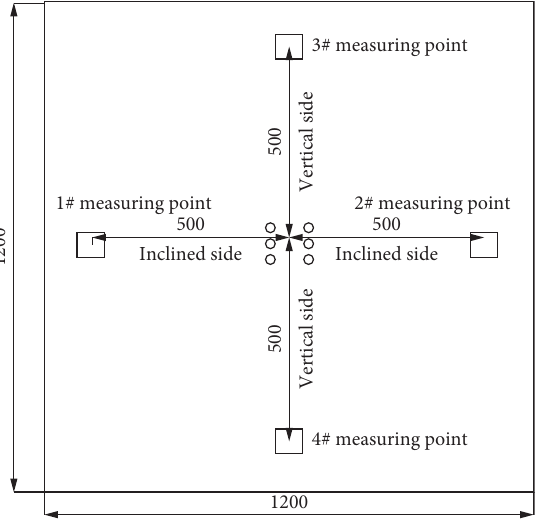
Figure 20: Schematic diagram of measuring points of wedge- shaped notch blasting vibration at different angles (unit: mm).